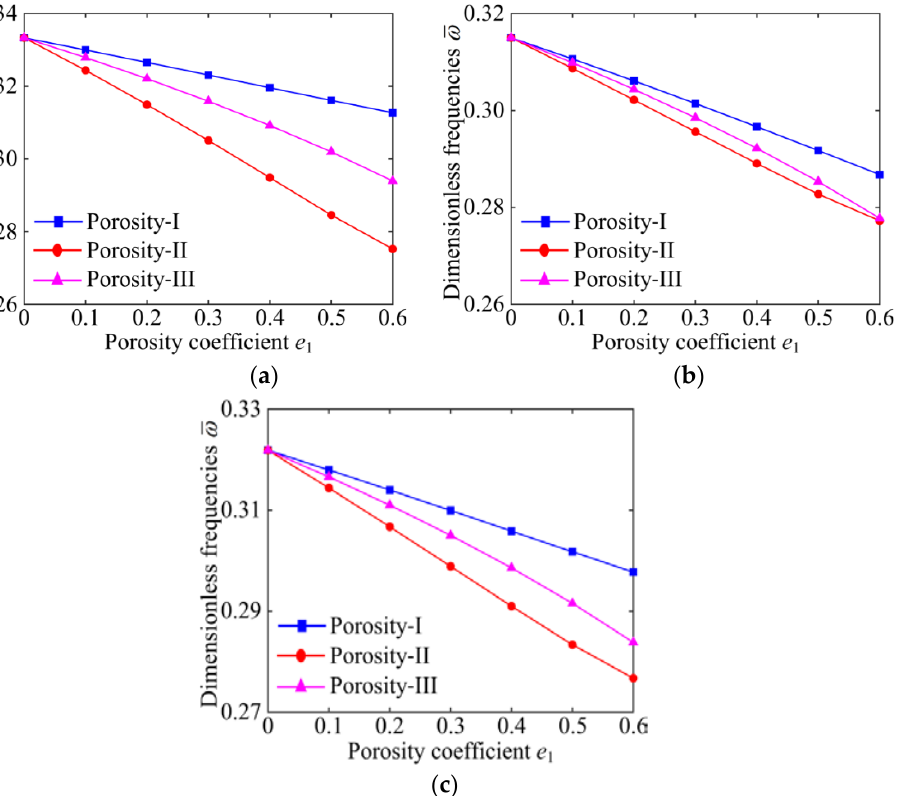
Figure 7. The influences of porosity coefficient on dimensionless fundamental frequencies of the GPLRP, two-cylindrical-panel system (SSSS). ( a ) GPL A; ( b ) GPL B; ( c ) GPL C.